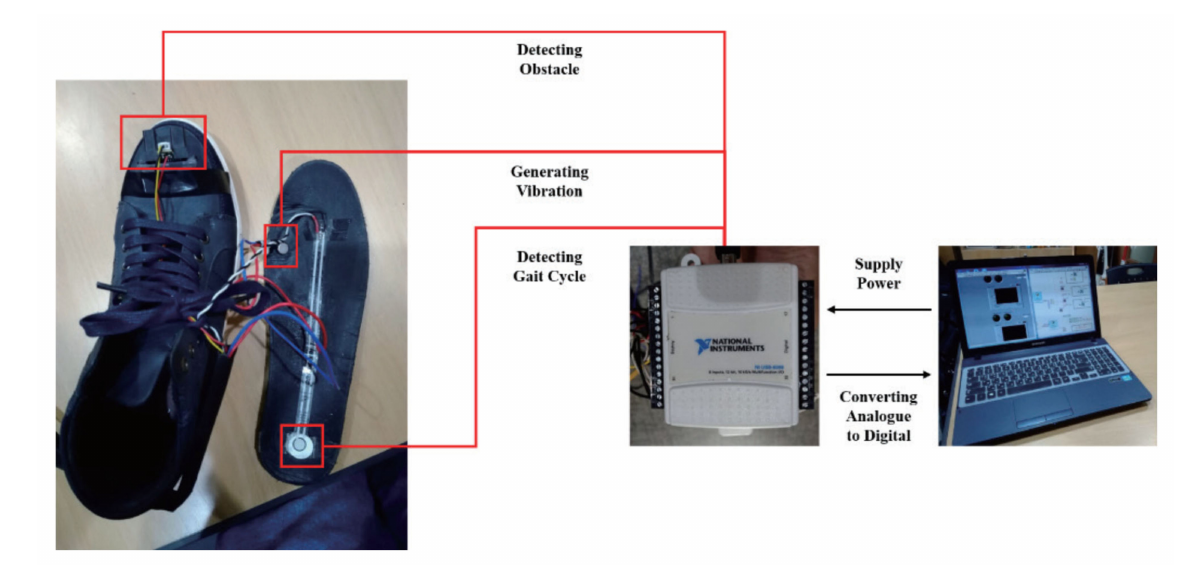
Figure 9. Shoe-worn obstacle and gait detection device